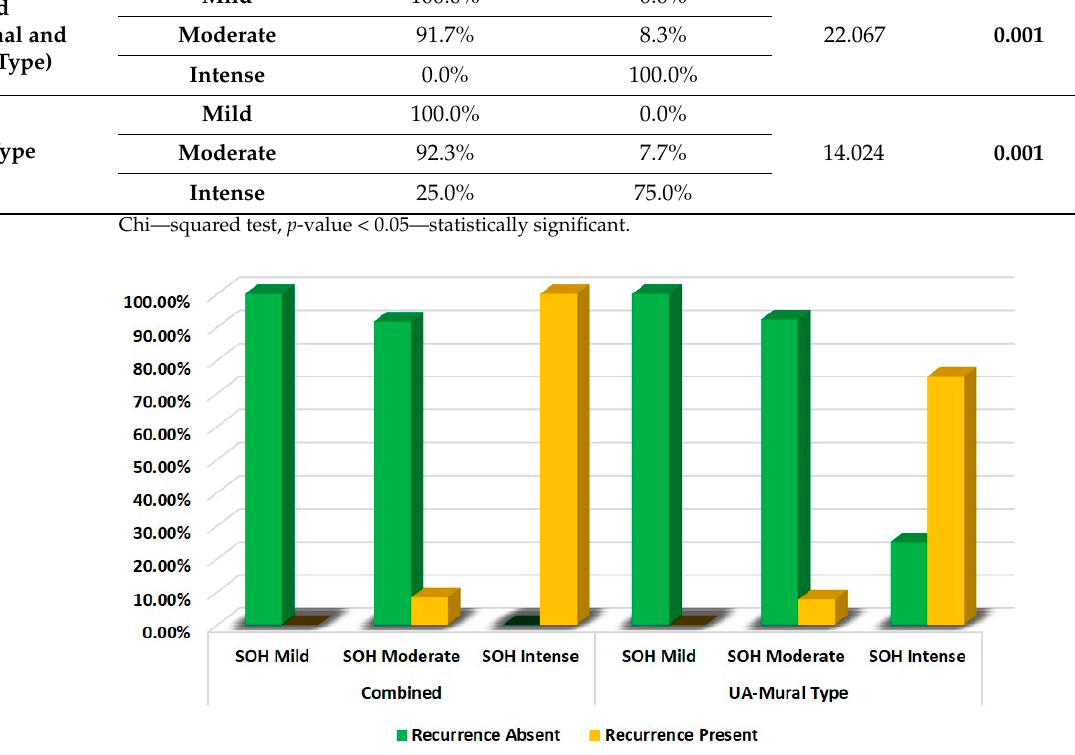
Figure 2. Comparison of correlation of SOH with recurrence of unicystic ameloblastoma combined (intraluminal/luminal) vs. mural type.